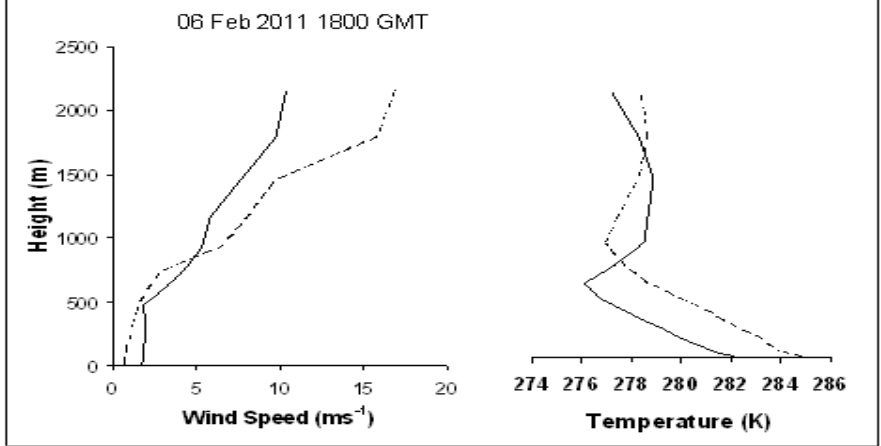
Figure 2. Vertical profiles of wind speed and temperature for the first 2.2 km at Block 703C on 12:00 LST 6 February 2011. Solid lines are simulations by MM5 and dashed lines are simulations by